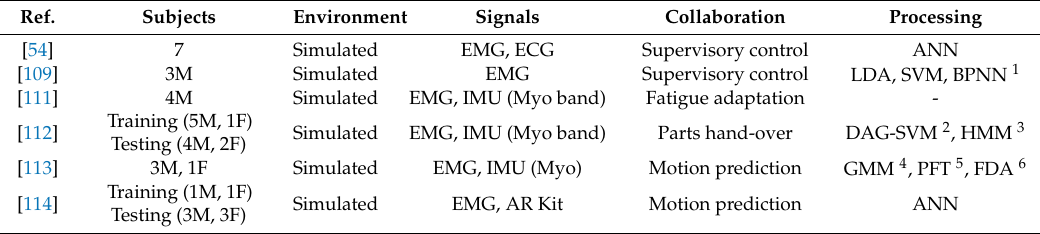
Table 4. Overview of EMG HMI collaboration systems experimental setups in production engineering.